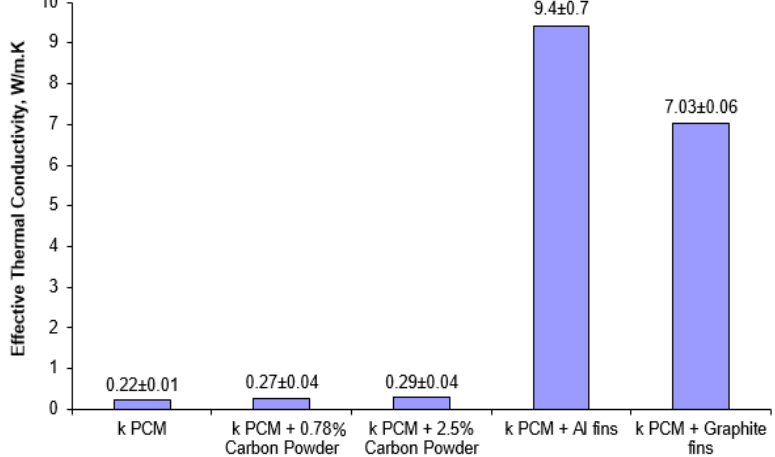
Figure 7. Effective thermal conductivity for pure and enhanced PCMs measured by cylindrical configuration method.